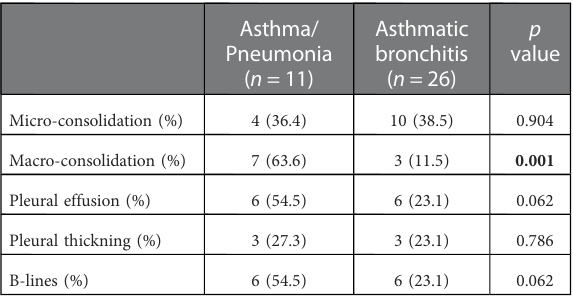
TABLE 4 Description of LUS abnormalities by asthma/pneumonia group and asthmatic bronchitis